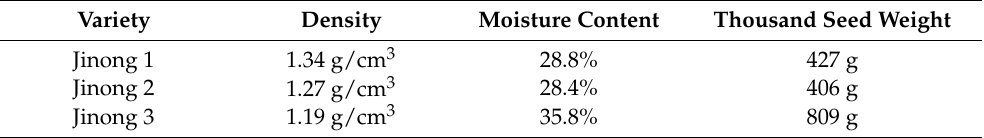
Table 1. Density, moisture content and thousand seed weight of the Cyperus esculentus seeds.